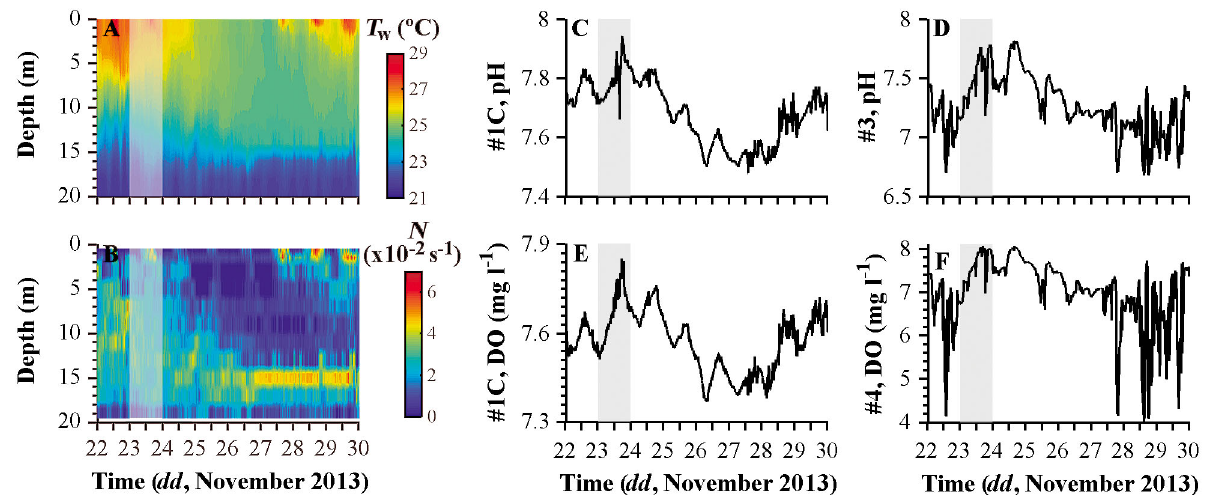
Fig. 8. Clipping of a short time-series of (A) water column temperature ( T w ), (B) buoyancy frequency ( N ), (C,D) pH values at platforms #1C and #3, and (E,F) dissolved oxygen (DO) concentrations at platforms #1C and #4, around a cold front passage event on November 23, 2013 (highlighted in